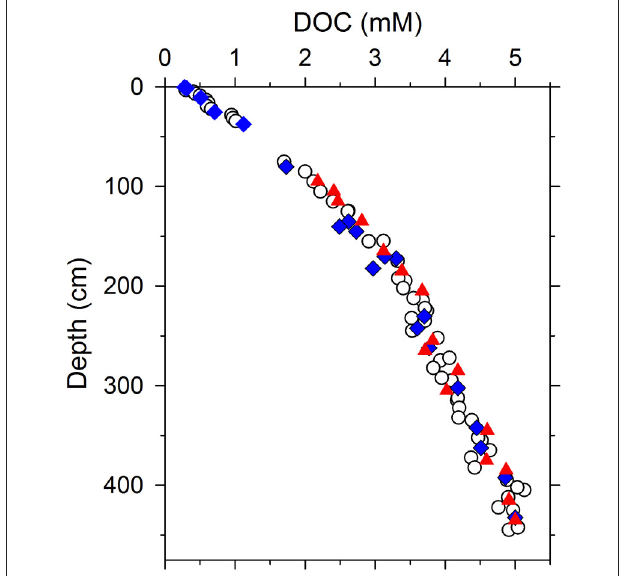
FIGURE 1 | Pore water DOC concentration profile from Santa Barbara Basin sediments showing data from one multicore (0–50cm; core 43,1) and three gravity cores ( > 50cm; G15, BB26, BB35; Burdige et al., 2016; Komada et al., 2016 ). All of the data shown were obtained by high-temperature combustion (Burdige and Gardner, 1998). Core G15 was collected in 2012; all others were collected in 2013. Circles represent samples analyzed for DOC concentration only. Blue diamonds and red triangles represent samples whose compositions were analyzed by 1 H NMR using a 400 MHz and 600 MHz spectrometer, respectively. One additional sample from 110cm was analyzed using the 400 MHz instrument, but not plotted here, because DOC concentration is not